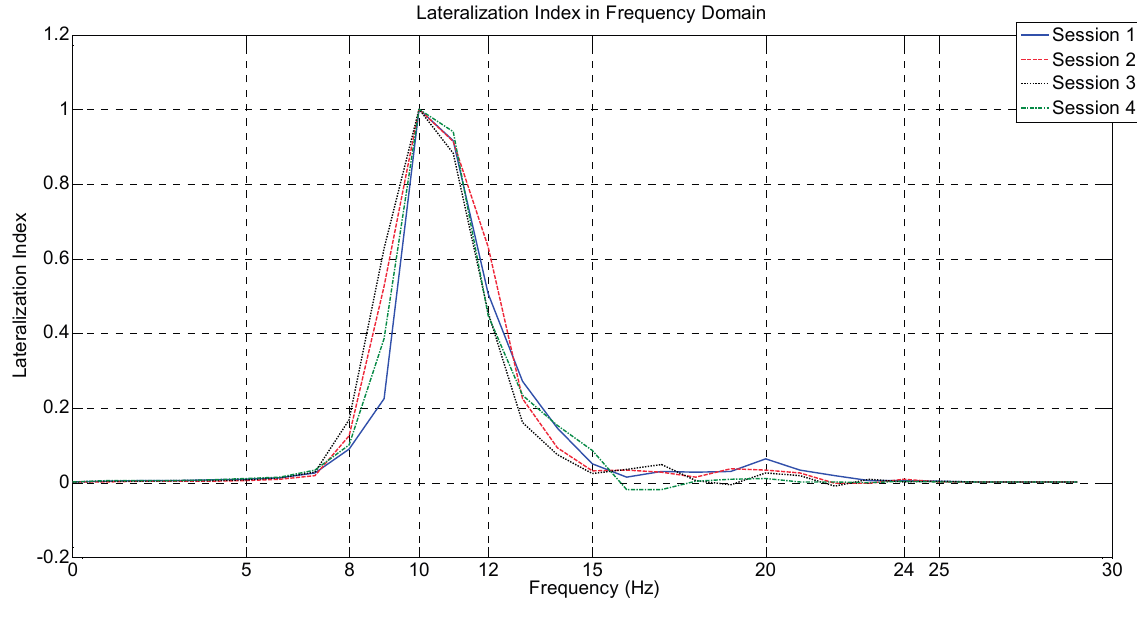
Figure 8. LI on the frequency domain for all